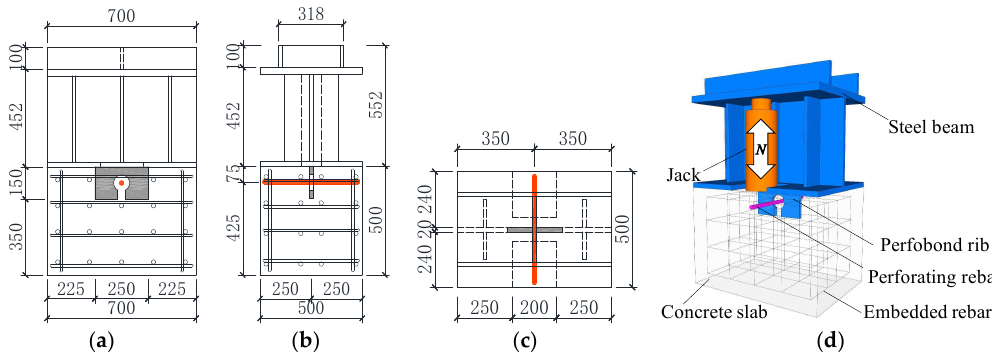
Figure 1. Layout of push - out test specimen. ( a ) Front view; ( b ) side view; ( c ) top view; ( d ) 3D view.